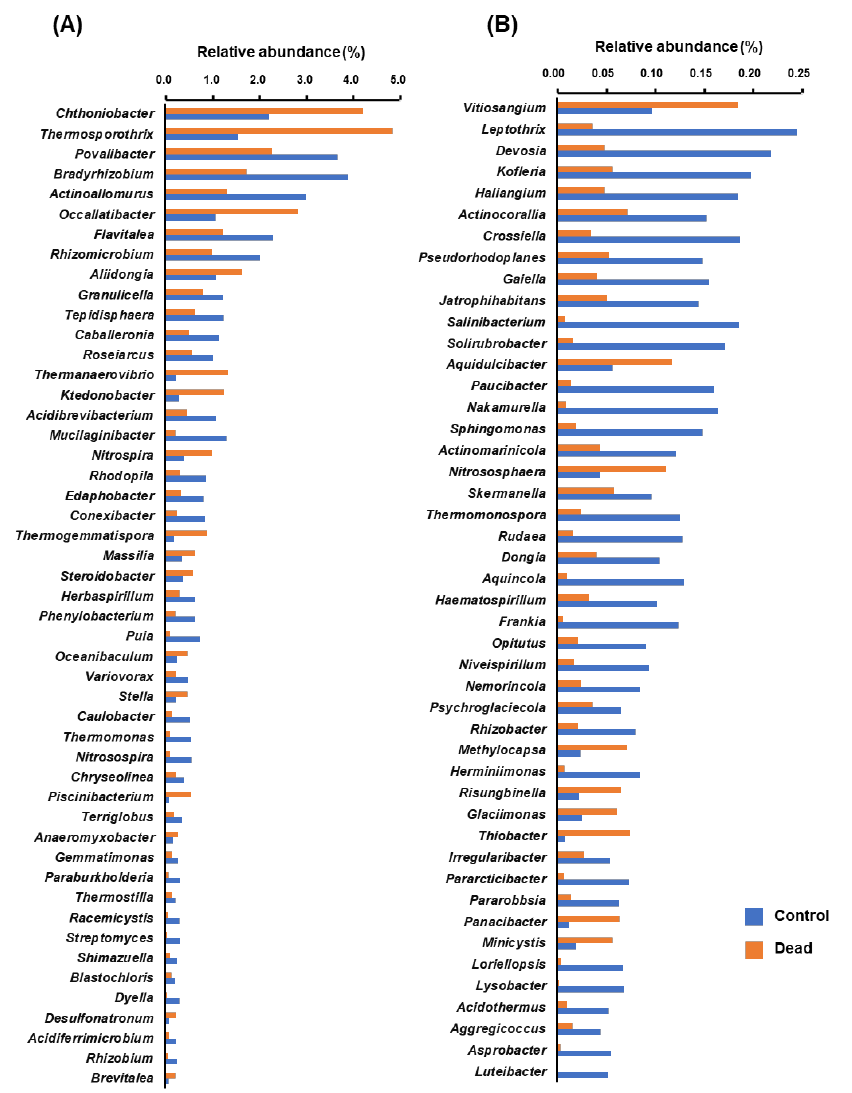
Figure 6. The bacterial genera with significantly higher ( p < 0.05) relative abundances between healthy and standing dead Korean fir tree rhizosphere microbiome compared to the control. Bars represent the mean values ( n = 15) of the relative abundance of the bacterial genera. ( A ) Bacterial genera represented relatively higher abundance levels (>0.28%). ( B ) Bacterial genera with relatively lower abundance levels (<0.28%).